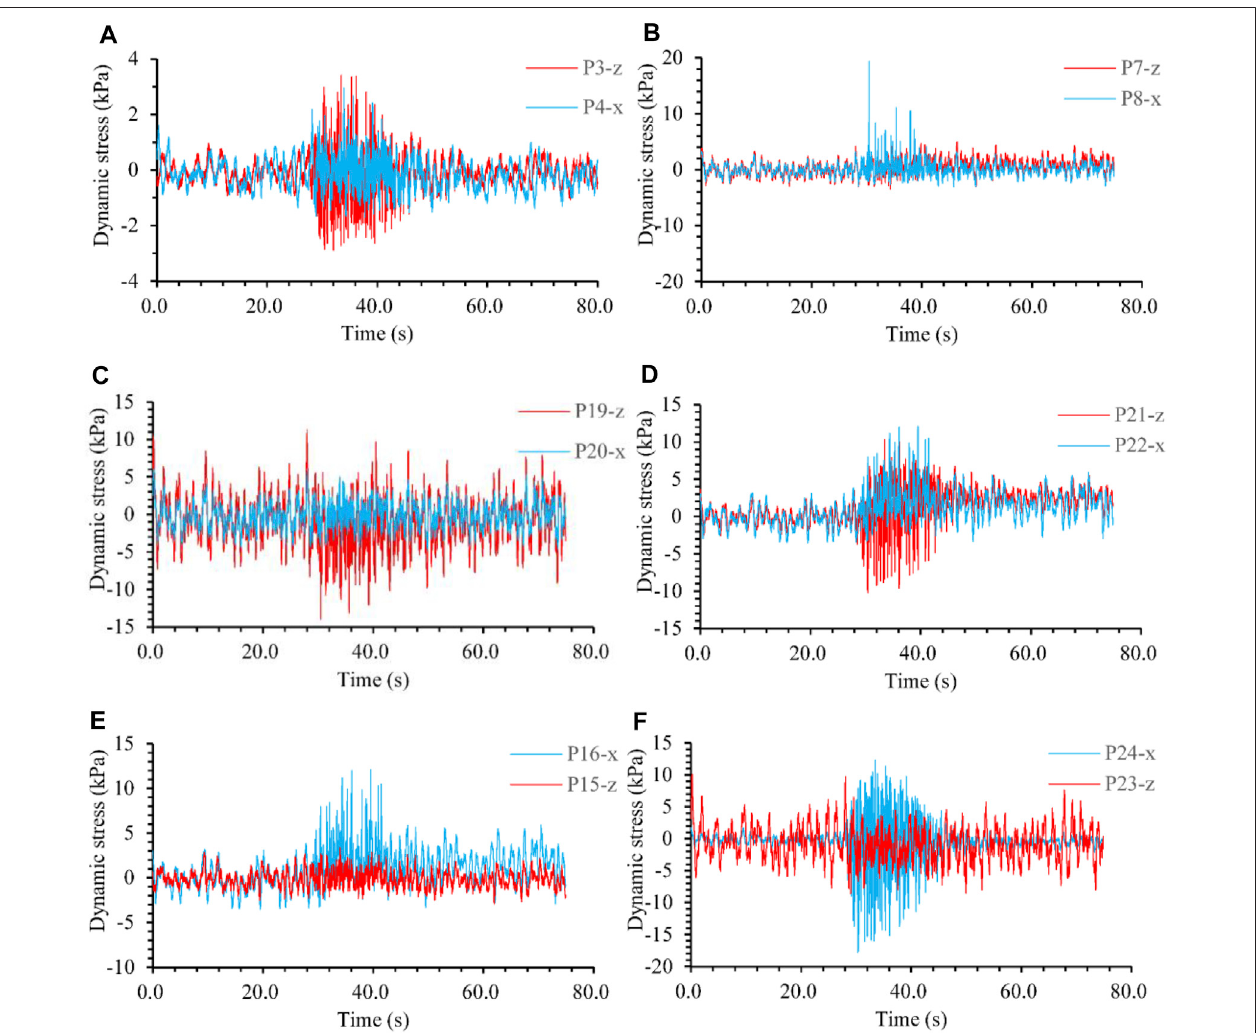
FIGURE 16 | Time history curves of dynamic stress in soil (loading No. 34, 1.1 g of the excitation peak acceleration). (A) stress at P3 and P4, (B) stress at P7 and P8, (C) stress at P19 and P20, (D) stress at P21 and P22, (E) stress at P15 and P16, and (F) stress at P23 and P24.